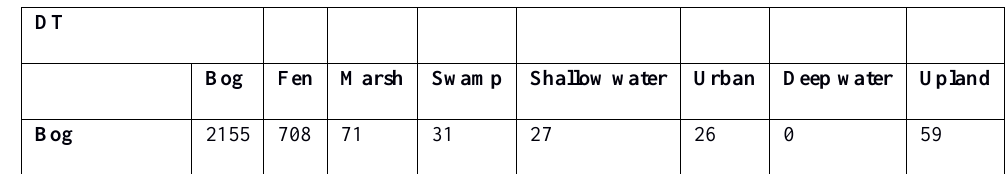
Figure 3. Wetland classification maps of the Avalon pilot site using the Decision Tree (DT), Random Forest (RF), and Extreme Gradient Boosting (XGB) in Google Earth